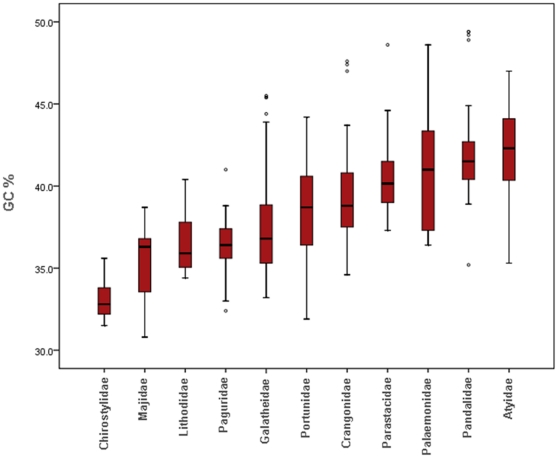
Boxplot distribution of ascending GC content (%) from 11 selected families.The number of sequences, species, and genera per family is indicated in Table 3 and statistic values in Table 4.